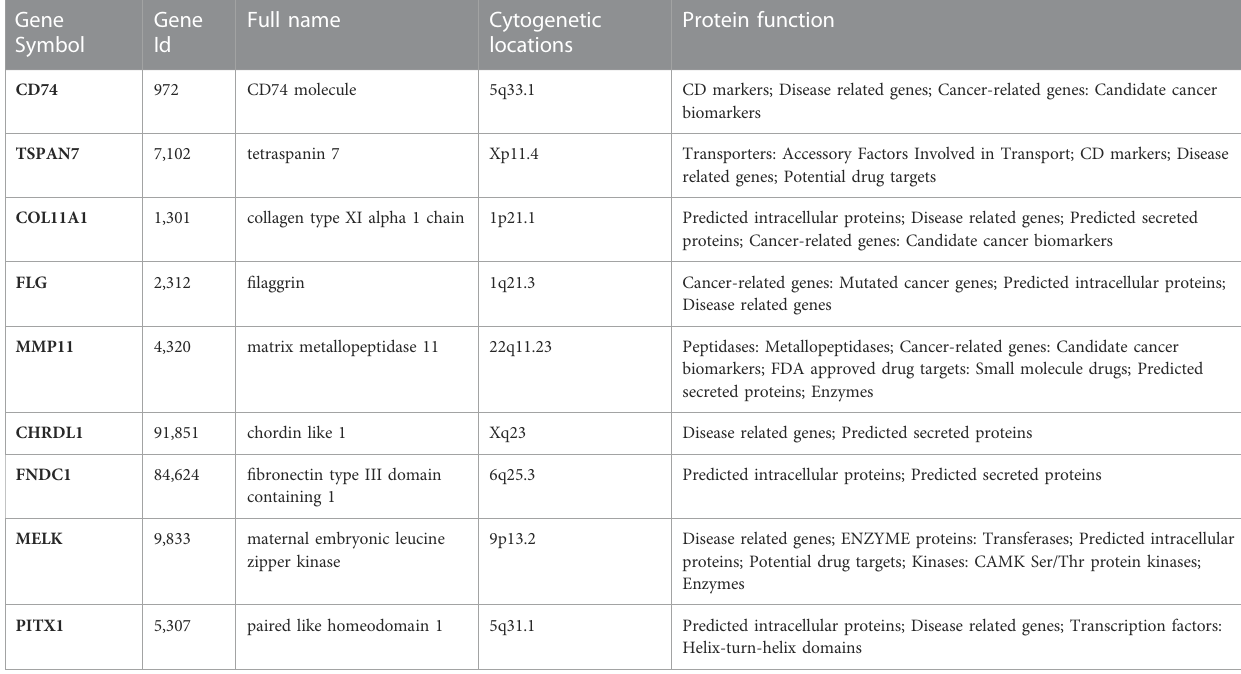
TABLE 2 Details of the candidate genes.